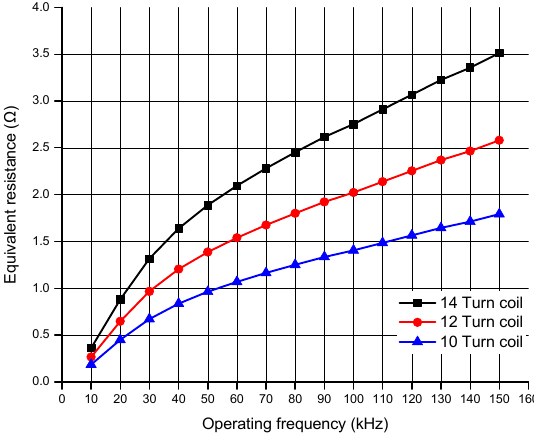
Figure 2. Equivalent resistance according to the number of coil turns and the frequency.